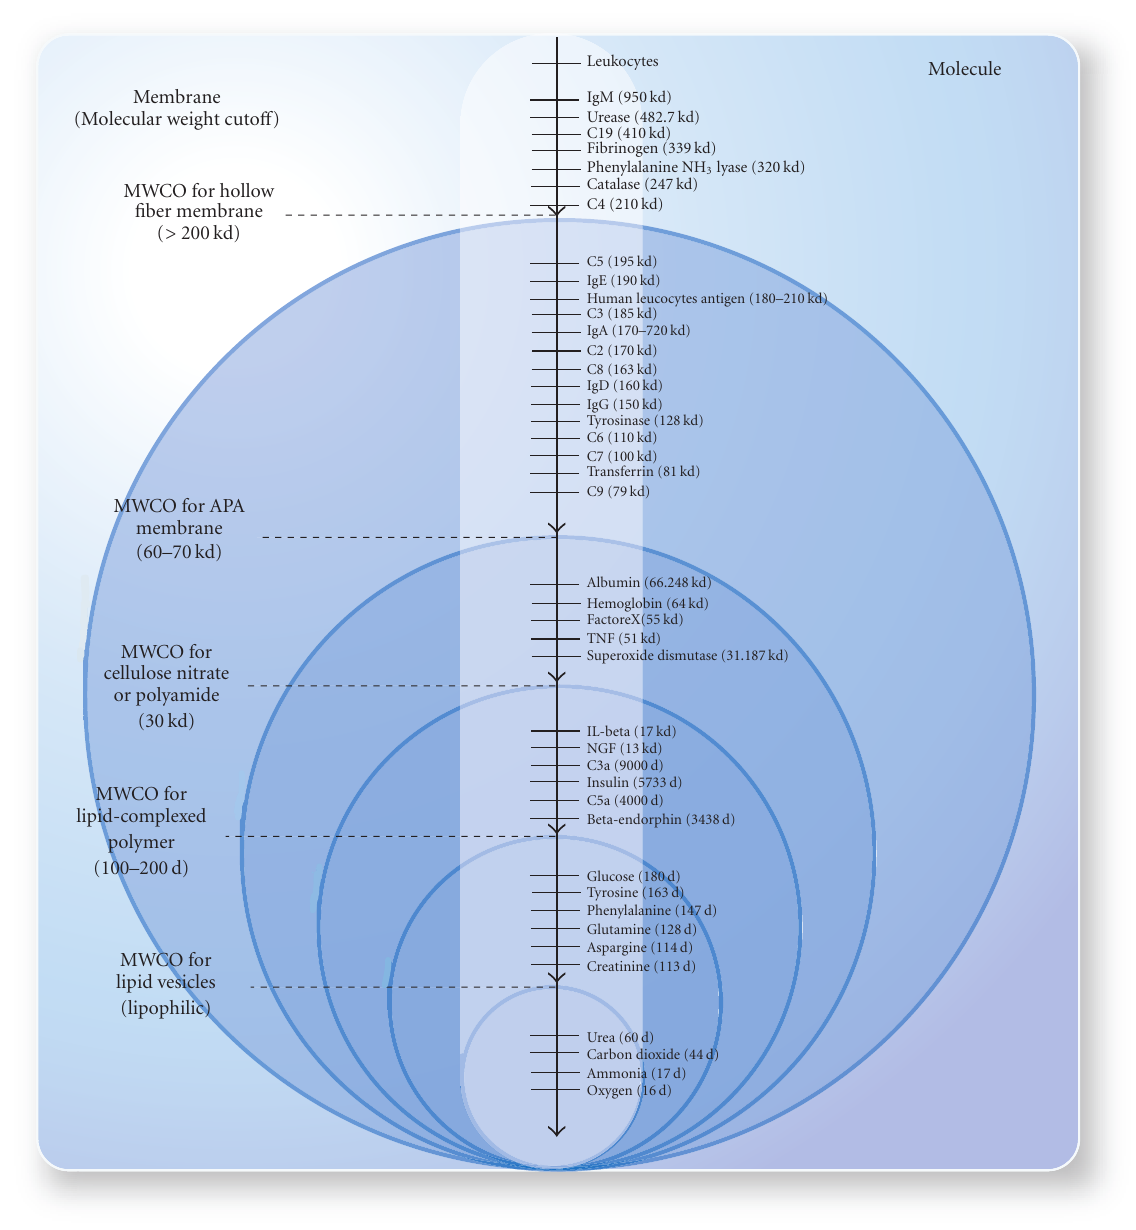
Figure 3. Molecular cuto ff of di ff erent types of microcapsule membranes [72]. The molecular weights of various cells, enzymes, antibodies, complement components, proteins, peptides, and metabolites are listed on the right. Abbreviations: C2–9 and C19, various components of the complement cascade; Ig, immunoglobulin; IL-1, interleukin 1; NGF, nerve growth